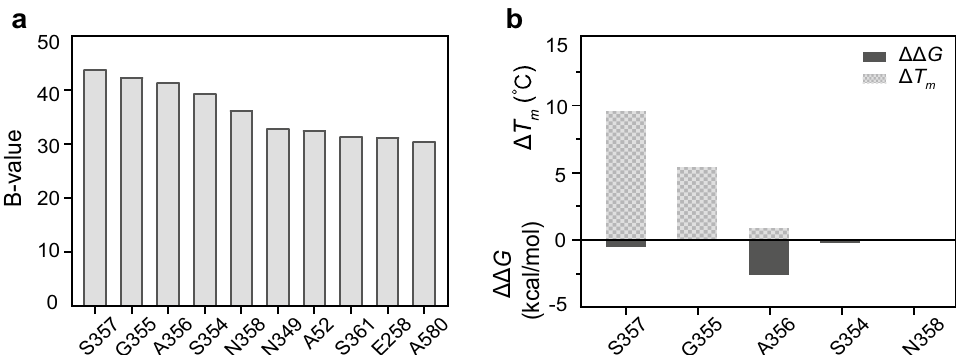
Fig. 1 Data statistics of thermostability of dextranase AoDex with predicted software. a The top 10 highest B-factor values of residues calculated by the B-FITTER software. b Aggregate data of ΔΔ G (kcal/mol) and Δ T m (°C) that calculated by the PoPMuSiC and HotMuSiC Web servers, respectively. The undetected values are not shown in the figure